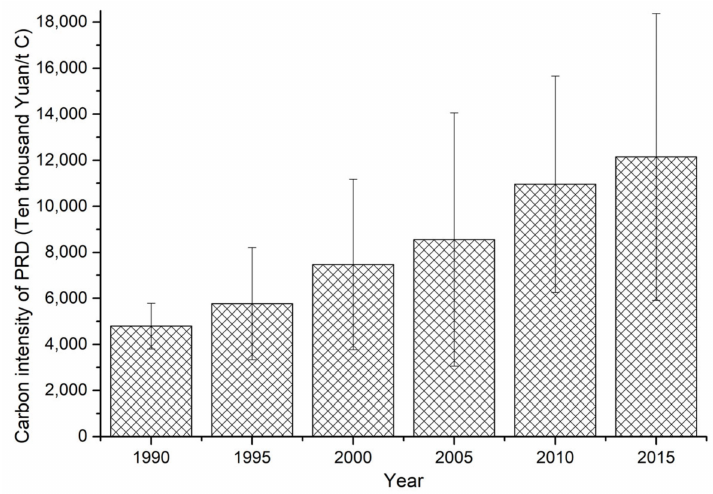
Figure 5. Average land-use-related carbon emissions intensity in the PRD. Note: Error bars show the standard deviation across the region.